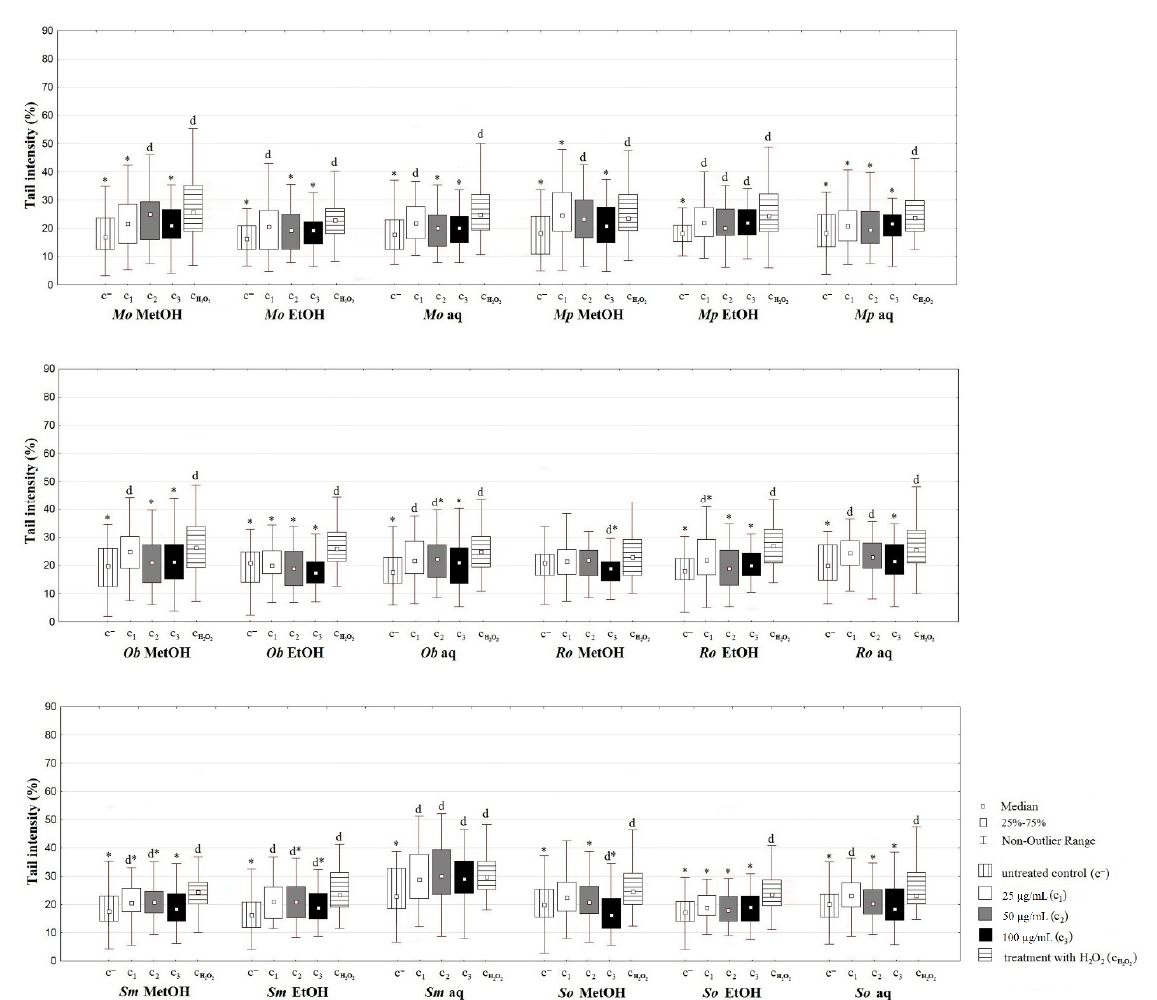
Figure 3. Comet assay performed on the MRC-5 cell line with the extracts’ concentrations of 25, 50, and 100 µ g/mL. MetOH, EtOH, aq—methanol, ethanol, and aqueous extracts, respectively. * p < 0.05—statistically significant decrease of DNA damage in comparison with the treated control (c H2O2 ); d p < 0.05—statistically significant increase of DNA damage in comparison with the untreated control (c − ).